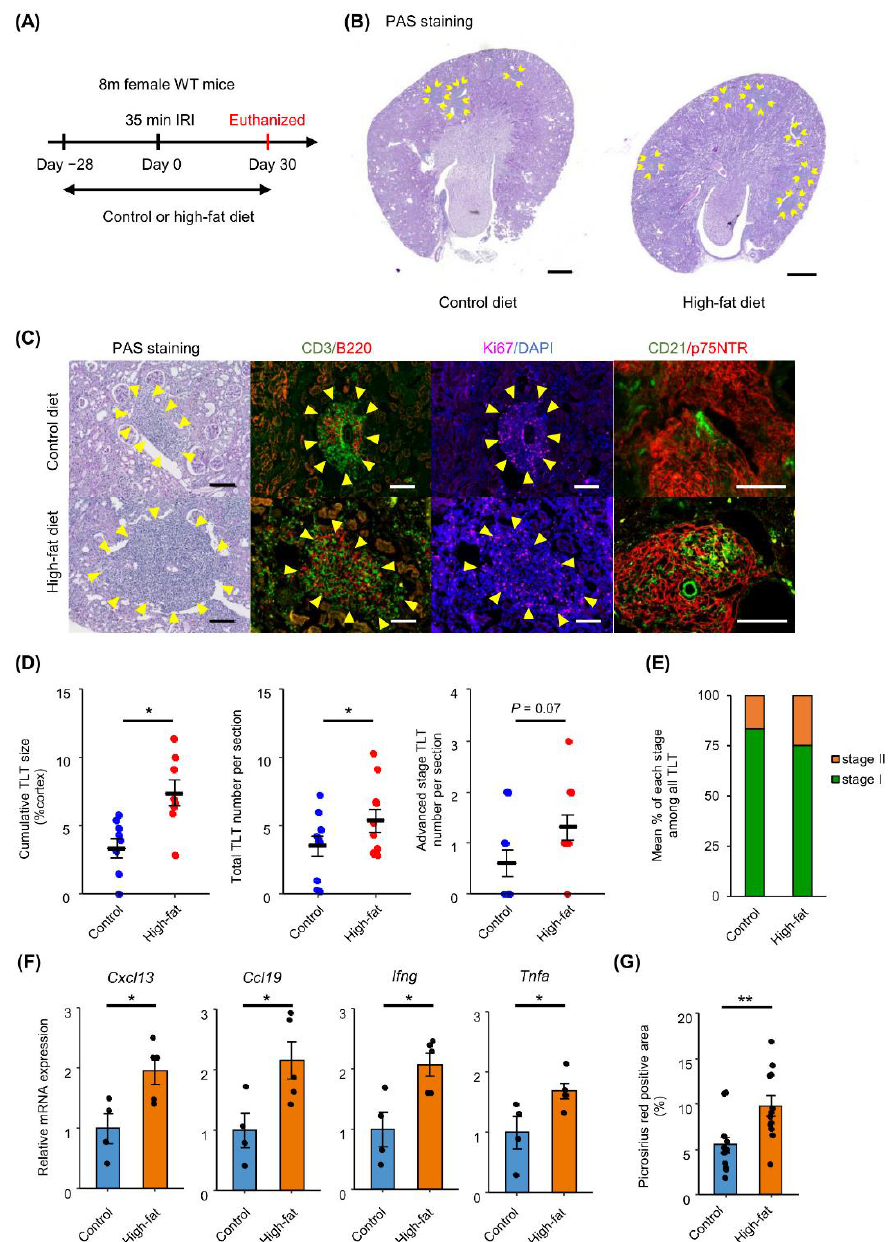
Figure 1. High-fat diet feeding promotes TLT formation in kidneys. ( A ) Experimental protocol. Wild-type (WT) 8-month-old female mice fed a control or high-fat diet (HFD) from 28 days prior to ischemic reperfusion injury (IRI). Diet was fed for 30 days after IRI. ( B ) Periodic acid – Schiff (PAS) staining of kidneys 30 days after 35 min IRI under control diet and under HFD. Arrows indicate TLTs. ( C ) PAS staining and immunofluorescence of TLTs under control diet and HFD. B220, CD3, Ki67, and DAPI were stained on the same section. CD21 and p75NTR were stained inside TLTs. Yellow arrows indicate TLT. ( D ) Cumulative TLT size per cortex (control diet n = 10, HFD n = 8), total TLT number per section ( n = 10), and advanced stage (stage II or III) TLT number per section ( n = 10). ( E ) Percentage of advanced stage TLTs detected in each sample ( n = 10). ( F ) Relative mRNA expressions of Cxcl13 , Ccl19 , Ifng , and Tnfa . Expressions are normalized with Gapdh expression and values are presented relative to control kidneys (control n = 4, HFD n = 5). ( G ) Quantification of Picrosirius red-positive fibrotic area comparing control-fed and HFD-fed mice after IRI ( n = 12). Values are mean ± S.E.M. Data were analyzed using student’s t -test, * p < 0.05, ** p < 0.01. Scale bars: ( B ) 500 µ